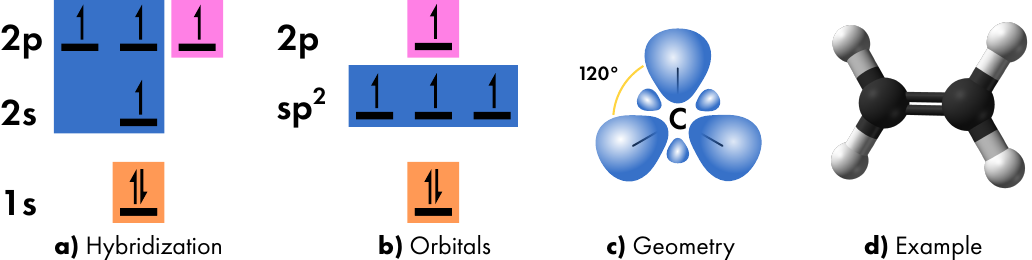
Figure 4. ( a ) sp 2 hybridization scheme and ( b ) resulting electronic configuration with hybrid orbitals,